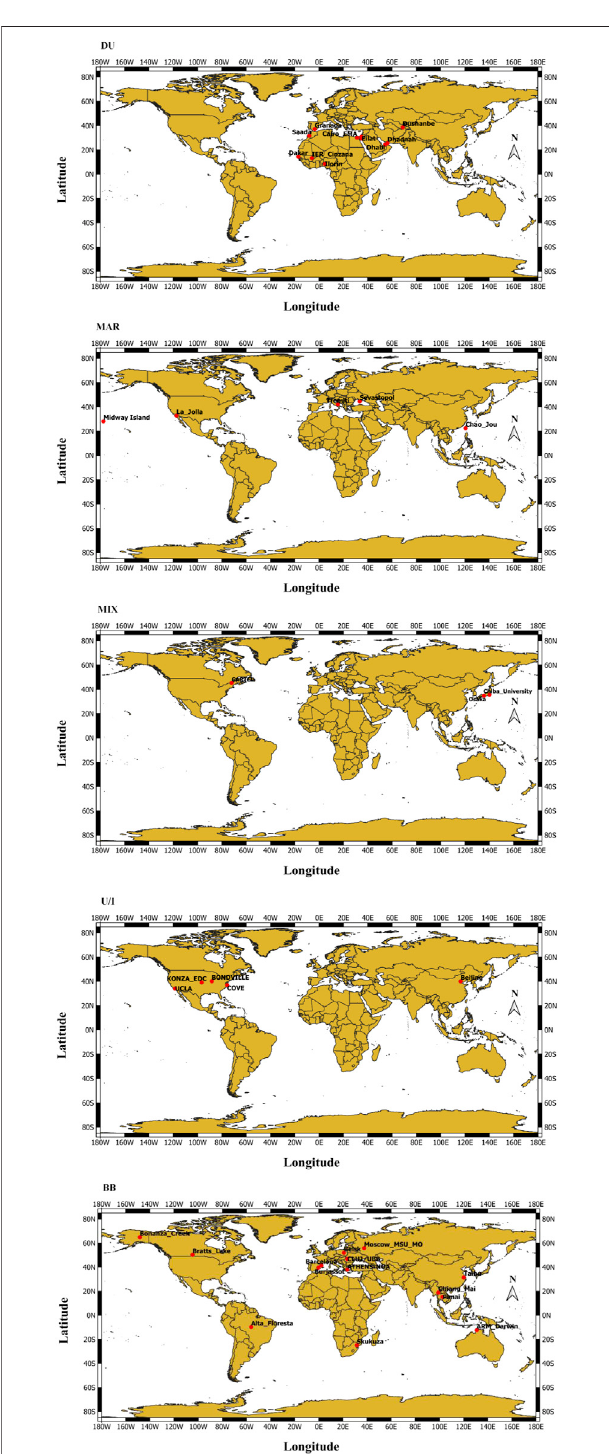
FIGURE 4 | Examples of PAM-derived aerosol types in AERONET sites. Sub-types 1 – 10. Examples of PAM-derived aerosol types in AERONET sites. Sub-types11 – 21.ExamplesofPAM-derivedaerosoltypesinAERONETsites. Sub-types 22 – 27.